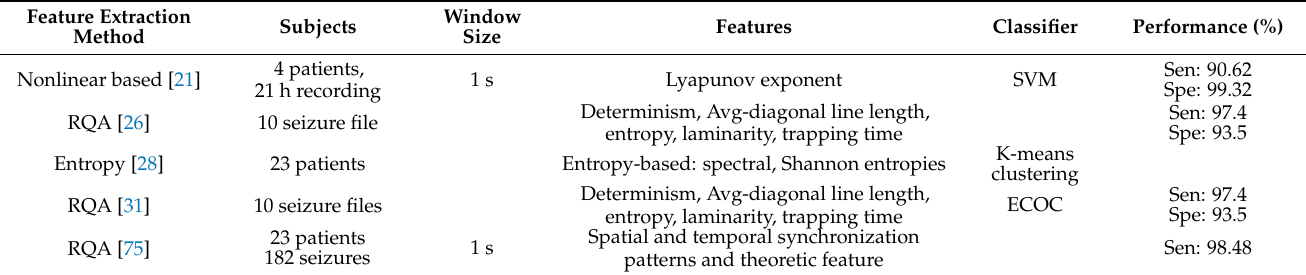
Table 4. Summary of epileptic seizure detection approaches in a nonlinear domain. Feature Extraction